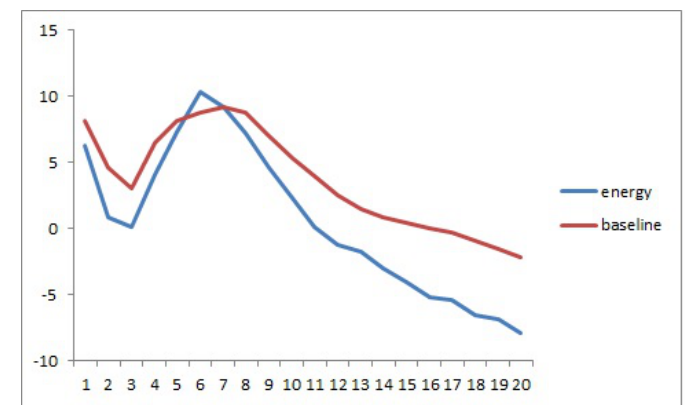
Figure A6. Comparison between energy and aggregate responses for bubbles.